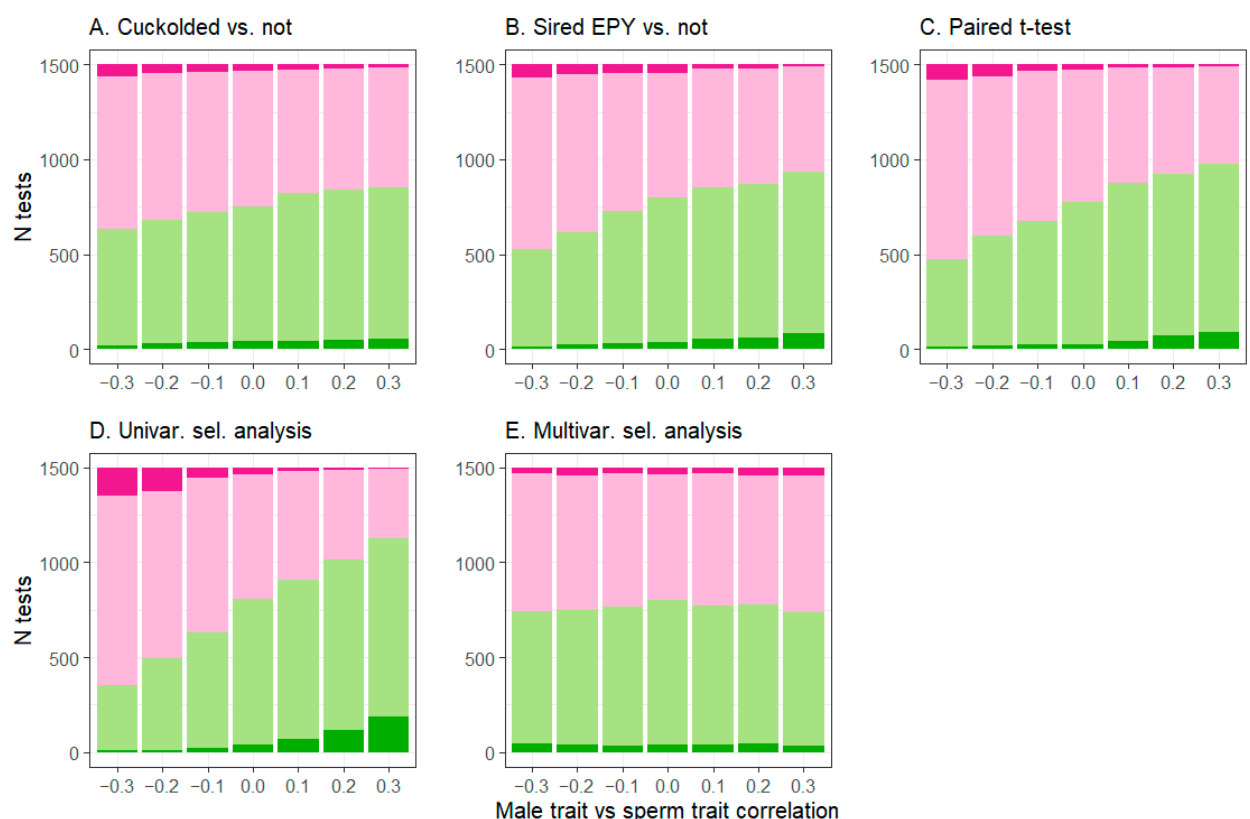
Figure 2. Spurious significant results for male traits (i.e., detected selection in individual populations where the male trait did not affect copulation success) were relatively uncommon for most analytical approaches. Pink colors indicate estimated negative selection and green colors indicate positive selection; intense colors are significant test results, while lighter colors are non-significant. Analytical approaches were ( A ): unpaired t-tests of males that lost paternity within their own broods (were cuckolded) or did not; ( B ): unpaired t-tests of males that gained extra-pair young (EPY) in other broods or did not; ( C ): paired comparisons of extra-pair sires to the within-pair males that they cuckolded; ( D ): univariate selection analysis regressing offspring sired on the male trait; and ( E ): multivariate selection analysis regressing offspring sired on both traits (with test results shown for the male trait only). Type 1 error is expected to produce only 5% (75) significant tests per column.